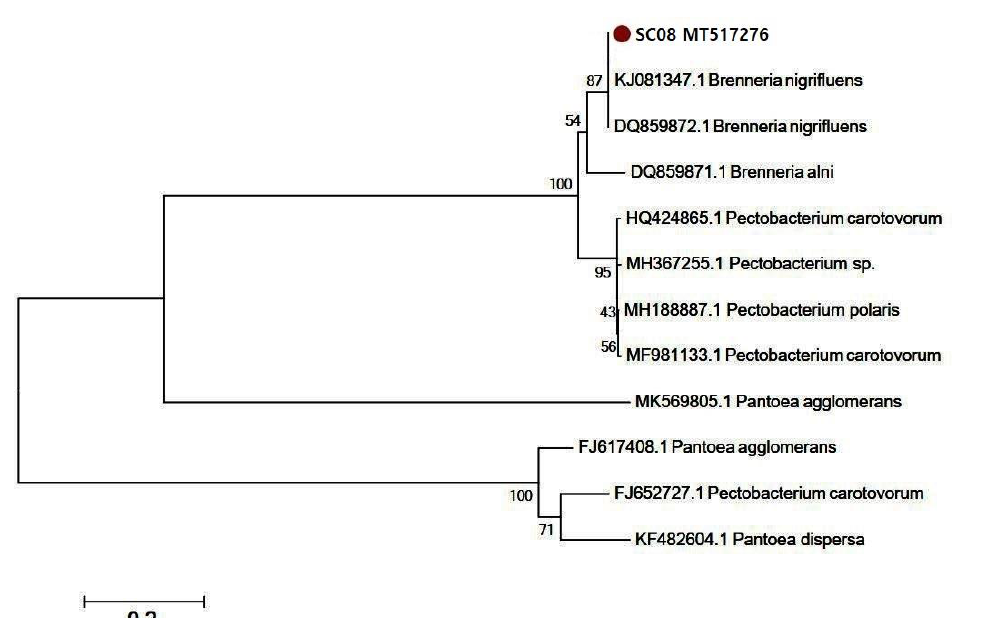
Fig. 5. Phylogenetic analysis of representative strain and related species by the neighborjJoining method based on recA gene sequences: The GenBank accession number for each microorganism used in the analysis is shown behind the species name. Bootstrap values are shown at the